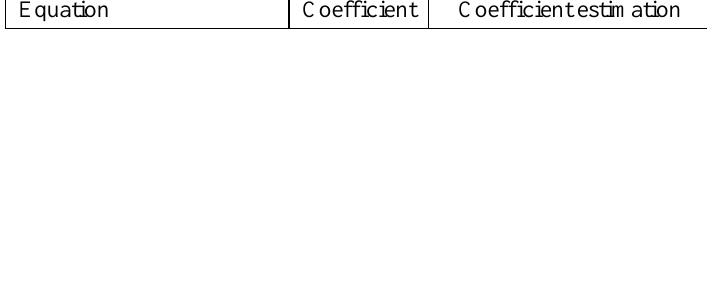
Table 8: Results of estimating the combined model of Kalman Filter